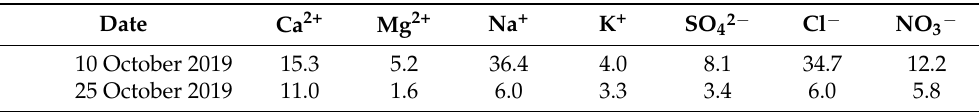
Table A1. Hydrochemical data of rainwater samples during the period October 2019 to December 2020 (number of samples = 15). The units are µeq·L − 1 .